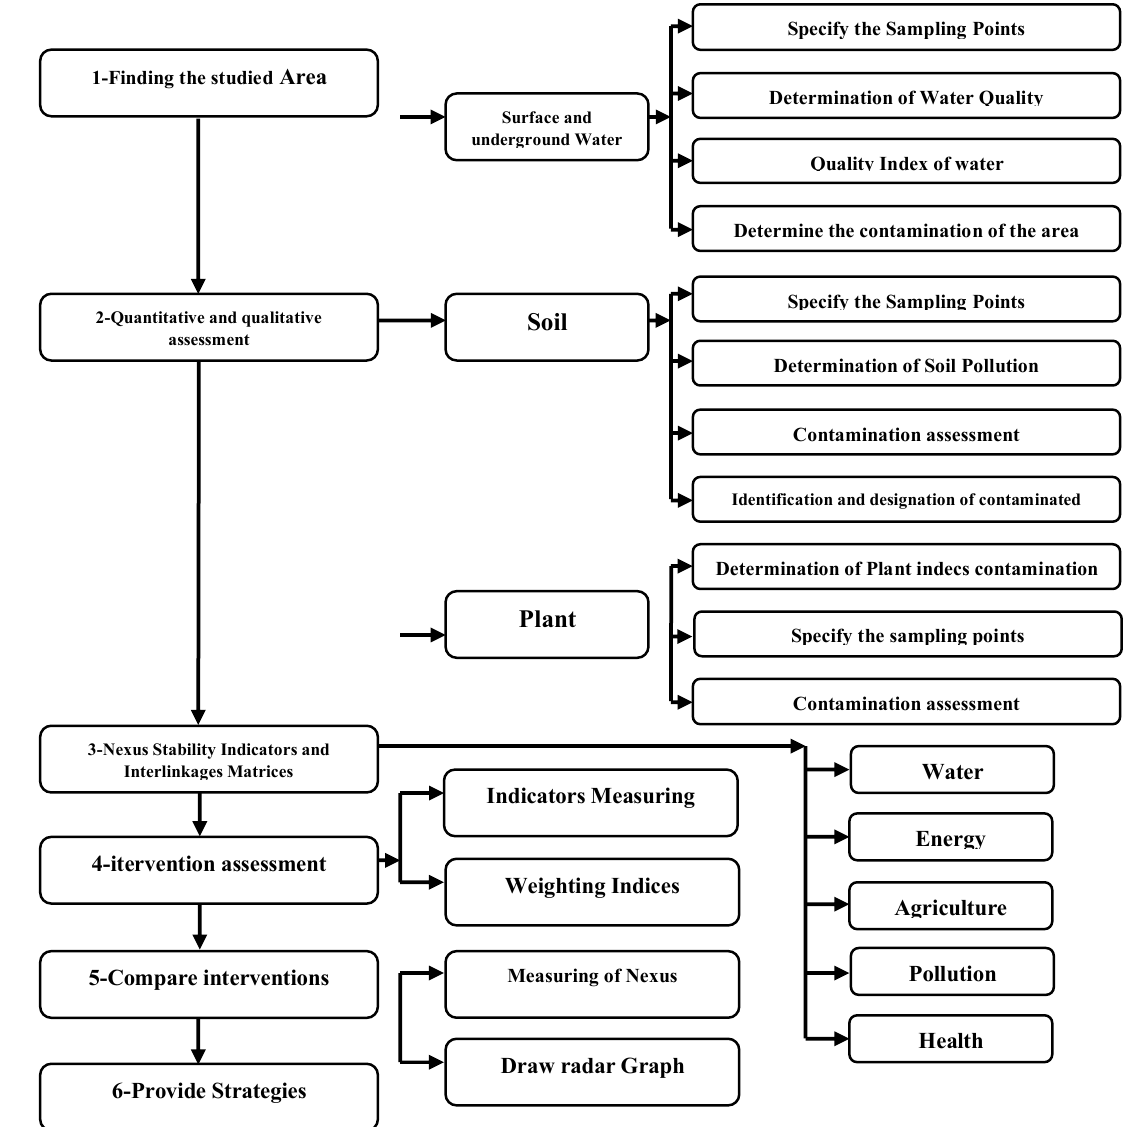
Figure 2. Methodology of Surface Water and Groundwater Quality Index (WQI) Evaluation in South of Tehran for Agricultural